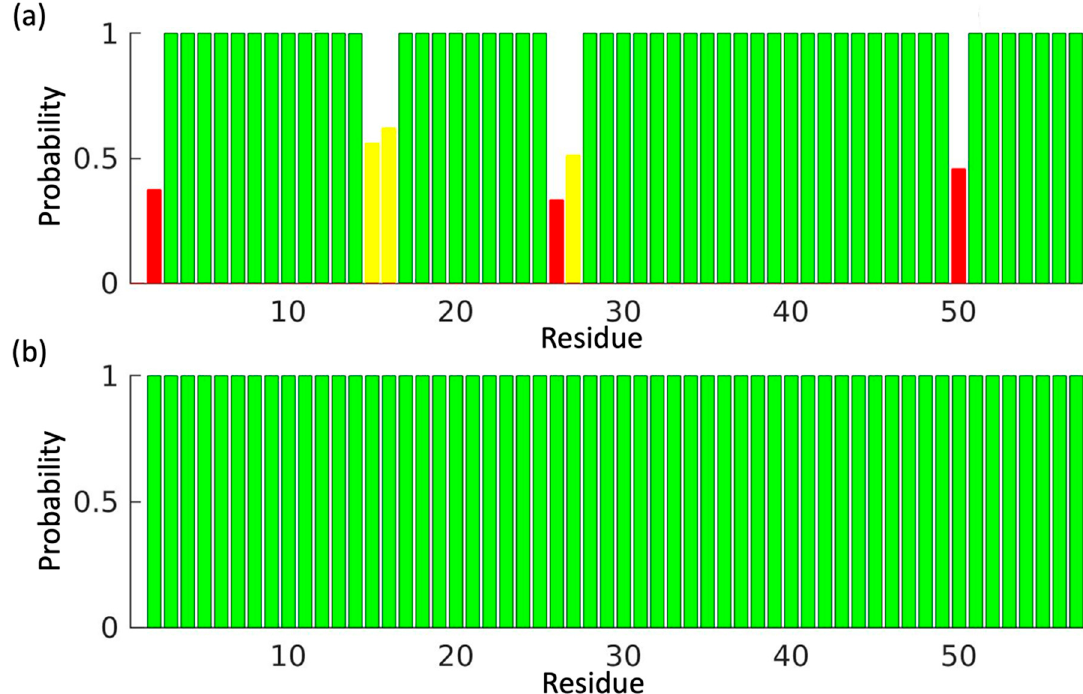
Figure 2. Bar graphs indicating the correct assignment probability ( p ) for each residue of GBI resulting from ssPINE analysis. Green indicates p greater than 0.99; cyan indicates p = 0.85–0.99; yellow indicates p = 0.5–0.84; red indicates p less than 0.5; and gray indicates no assignment (not seen with these test sets). ( a ) Unrefined GBI data as input. ( b ) Refined GBI data as input.